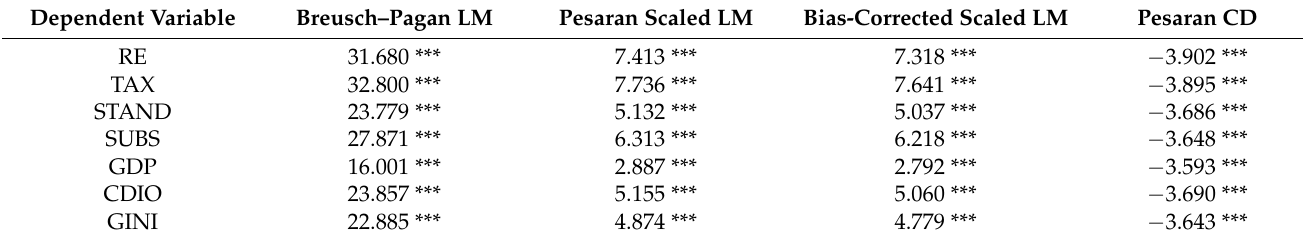
Table 6. Cross-sectional dependency test (CD) for model